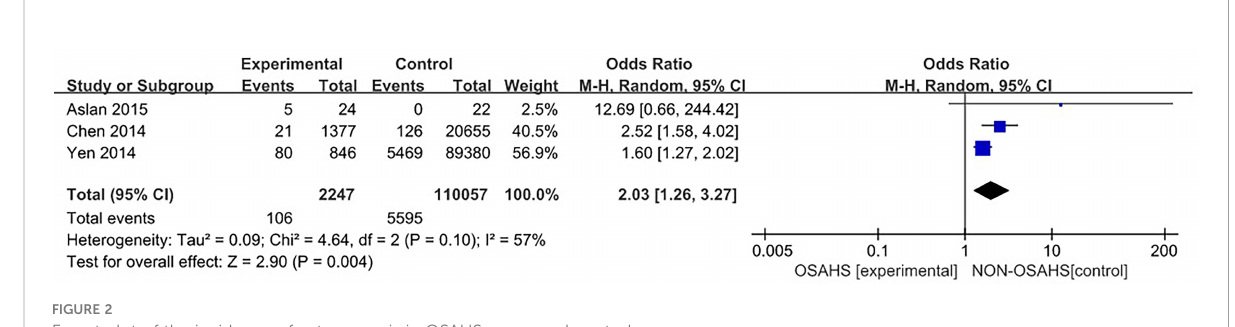
FIGURE 2 Forest plot of the incidence of osteoporosis in OSAHS group and control group.